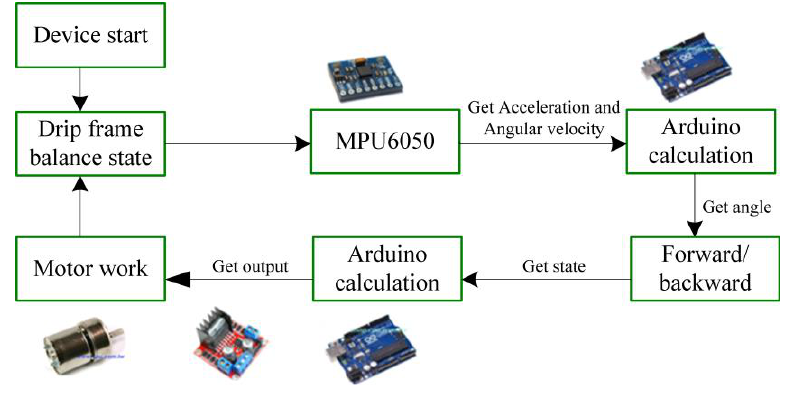
Figure 6. The conceptual system workflow.